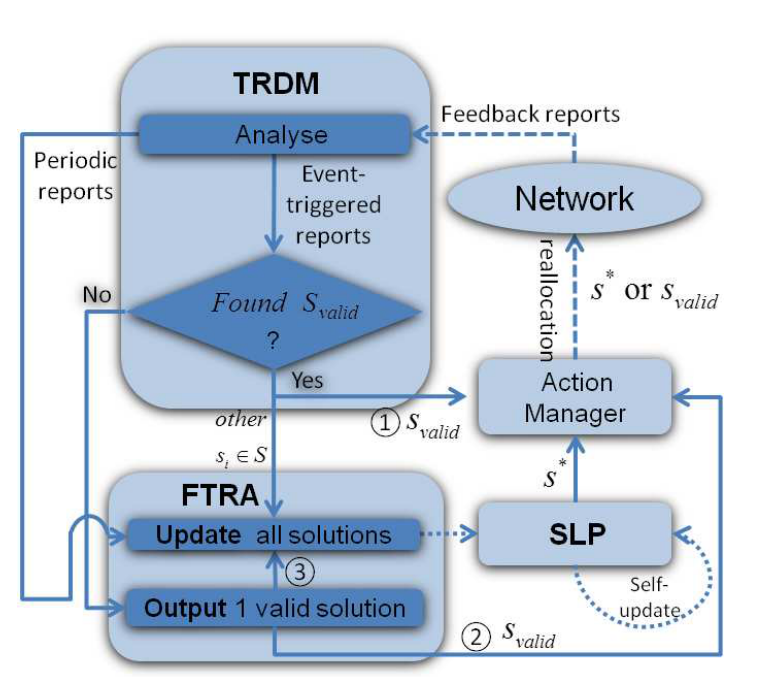
Figure 6. Task Reallocation Decision Maker (TRDM) function